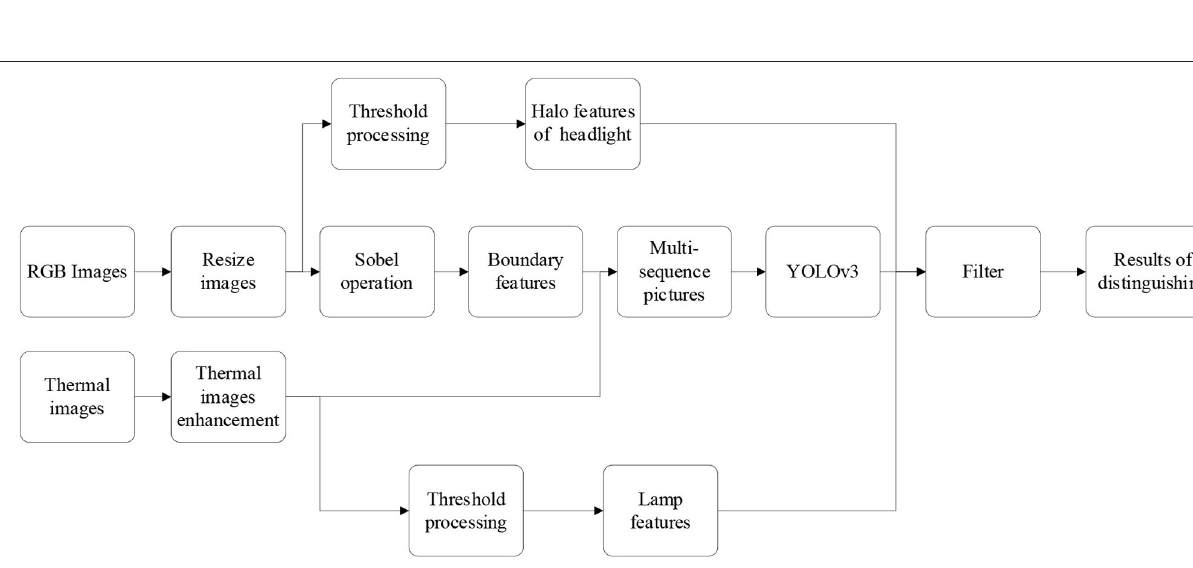
FIGURE 11 | Flowchart of dynamic adjustment and distinguishing